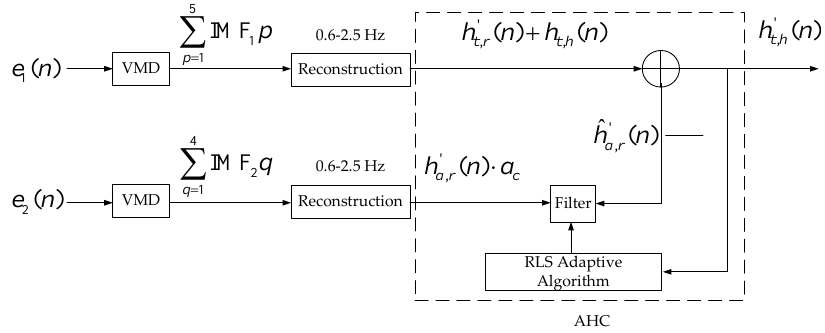
Figure 4. Block diagram of respiratory harmonics signal elimination: e 1 ( n ) is the motion signal of the chest after removing the RBM signal; e 2 ( n ) is the motion signal of the abdomen after removing the RBM signal. VMD: Variational Mode Decomposition; IMF: Intrinsic mode function; AHC: adaptive harmonics cancellation.